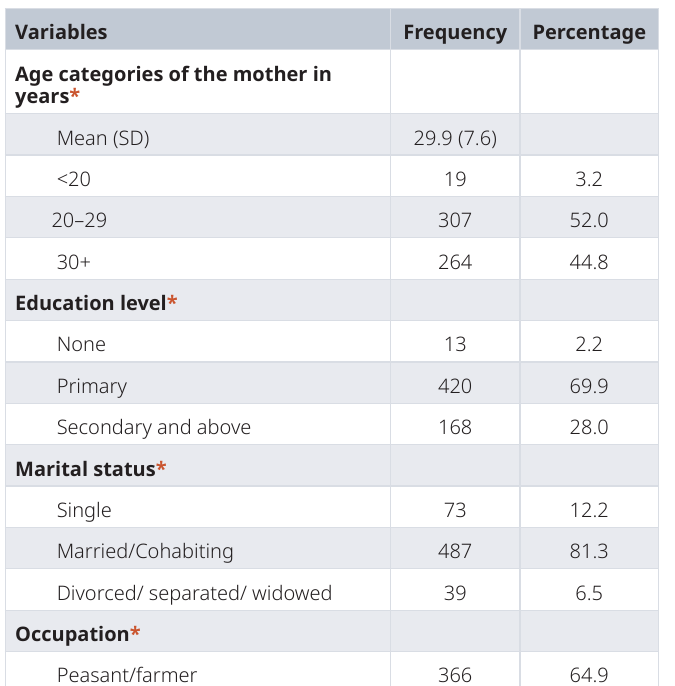
Table 1. Background characteristics of mothers and children